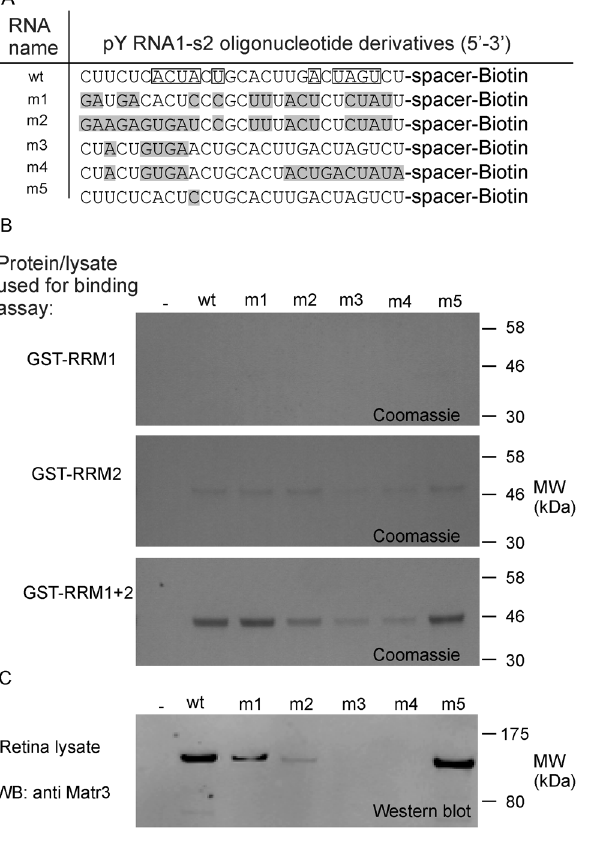
Figure 9. Isolated RNA recognition domains and endogenous Matr3 bind to pY RNA1-s2 in a sequence specific manner. A. Details of RNA oligonucleotides used to examine the interaction with Matr3. Mutated bases with respect to wild type ( wt ) are indicated with grey shading ( m1 , m2 , m3 , m4 and m5 ). ‘‘Spacer’’ indicates an 18C spacer moiety attached to the 3 9 end of the RNA, terminated with Biotin. Boxed residues indicate a pseudo-palindrome sequence. B. Derivatives of Matr3 conjugated with GST were incubated with the indicated RNA oligonucleotide. The constructs are detailed in Figure 8B and comprise: GST-RRM1, GST-RRM-2 and GST-RRM1 + 2 respectively. The interaction was examined by Streptavidin conjugated magnetic bead pull-down experiments: the bound protein is revealed by SDS- PAGE analysis followed by Coomassie blue staining. C. Matr3 is identified by western blot, revealing the interaction of pY RNA1-s2 and mutants with native Matr3. Lysate prepared from rat retina was incubated with the same pY RNA1-s2 mutants as used in B